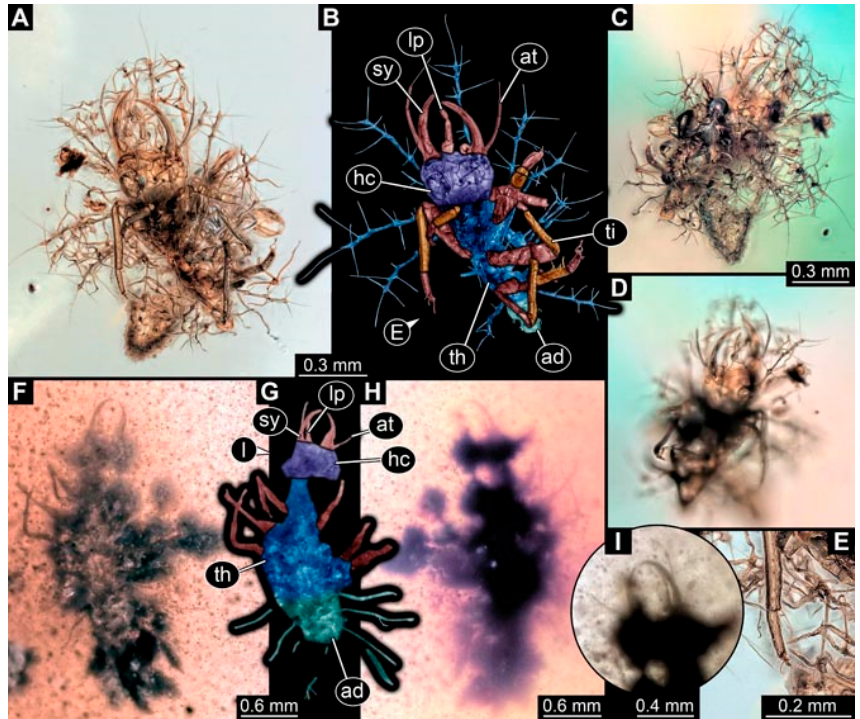
Figure 31. Two specimens in Myanmar amber. ( A – E ) Specimen 4855 (PED 0793). ( A ) Ventral view. ( B ) Ventral view, colour-marked. ( C ) Dorsal view. ( D ) Antero-dorsal view. ( E ) Close-up of trunk appendage. ( F – I ) Specimen 4856 (PED 0807). ( F ) Ventral view. ( G ) Ventral view, colour-marked. ( H ) Dorsal view. ( I ) Close-up of head capsule in ventral view. Abbreviations: ad = abdomen; at = antenna; hc = head capsule; lp = labial palp; sy = stylet; th = thorax; ti = tibia.